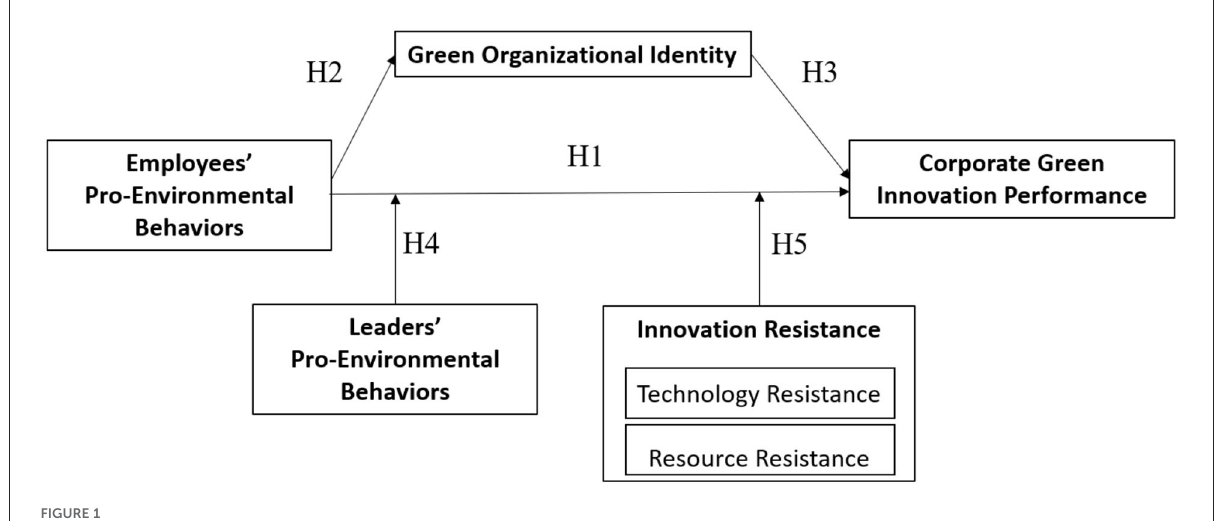
FIGURE1 Research